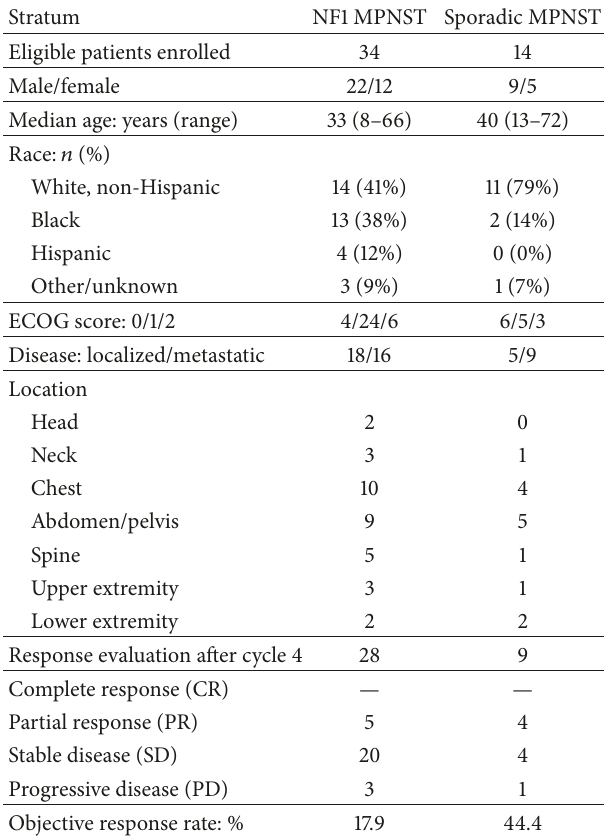
Table 2: Baseline NF1 clinical findings in 34 patients with NF1